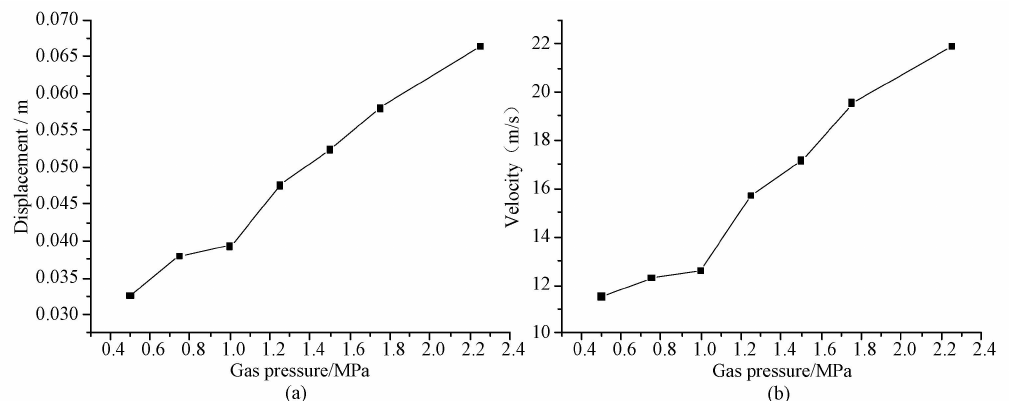
Figure 10. The maximum displacement and velocity statistics of the fracture block of coal samples with different pore gas pressures: ( a ) maximum displacement comparison of fracture coal blocks and ( b ) maximum velocity comparison of fracture coal blocks.